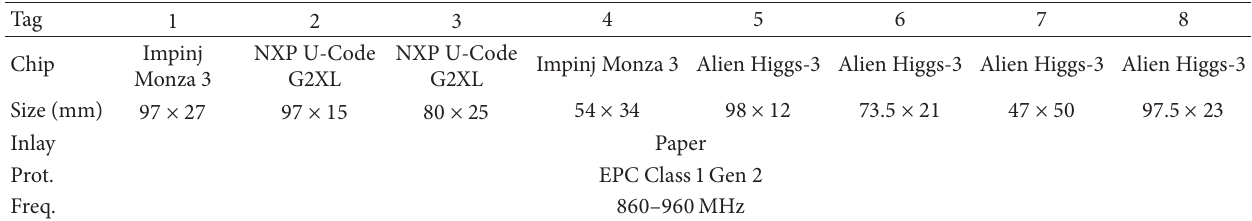
Table 2: Characteristics of the RFID tags used in the tests.